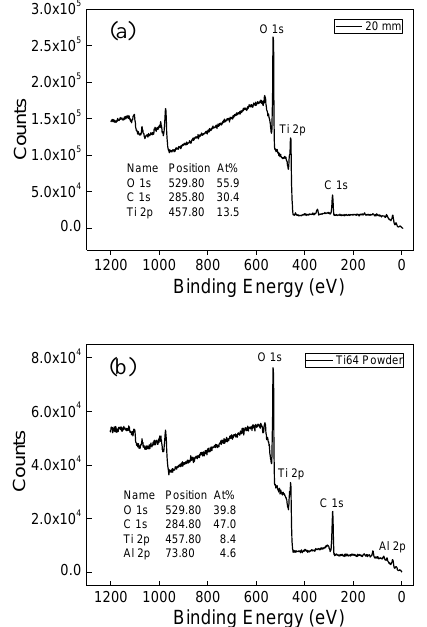
Figure 7. XPS survey spectra for ( a ) the 20 mm EBM-built Ti64 sample and ( b ) the Ti64 powder.